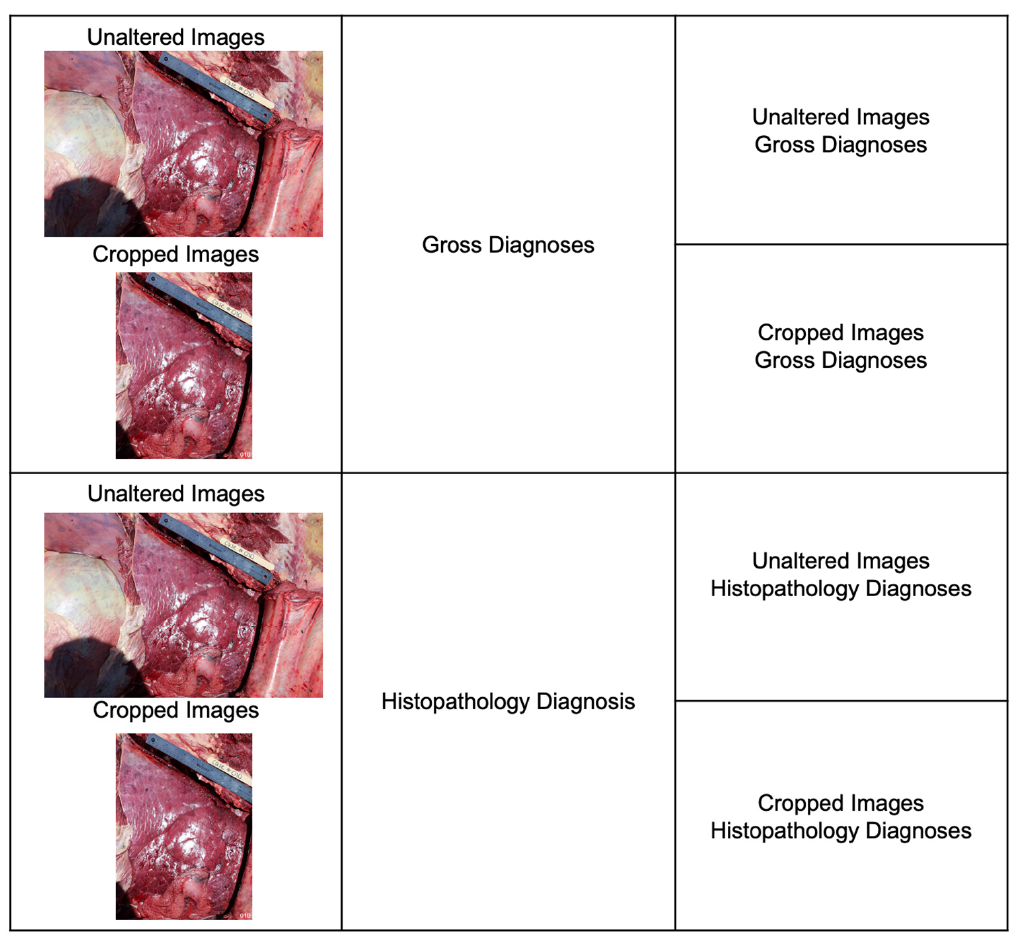
Figure 3. Four image classification data sets were created pairing unaltered and cropped lung images to their respective gross and histopathological diagnoses.